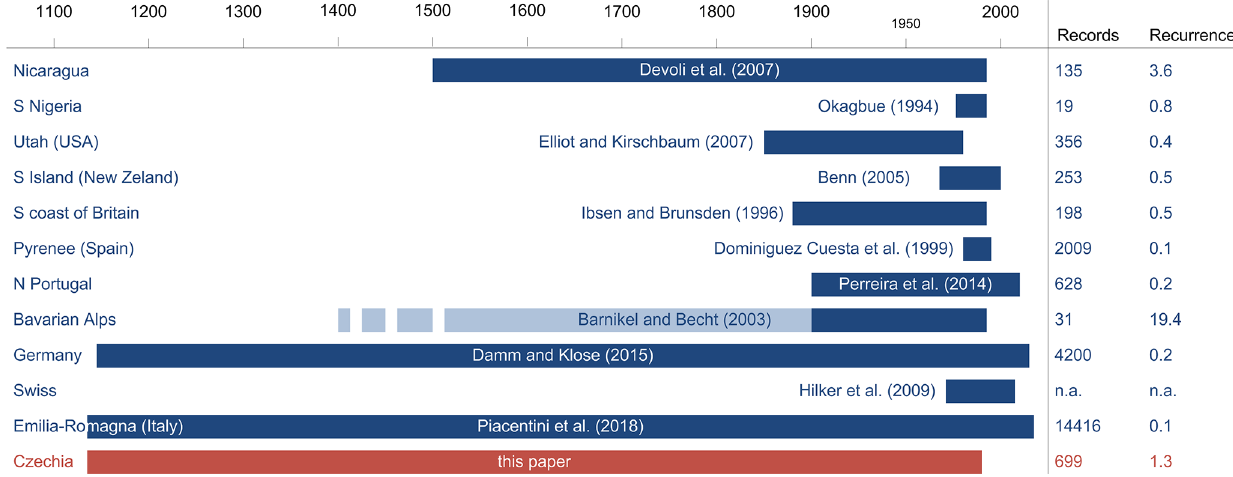
Figure 9. Comparison of CHILDA and other existing historical landslide databases in terms of the number of records and recurrence. Note: dark-blue stripes mark the periods under study. In the case of compound (multi-hazard) databases, light-blue marks complete the studied period for which geohazards other than landslides have been found, whereas dark-blue stands for landsliding. Dashed stripes represent an unspecified beginning (e.g. since the fifteenth century without explicit dating of the oldest